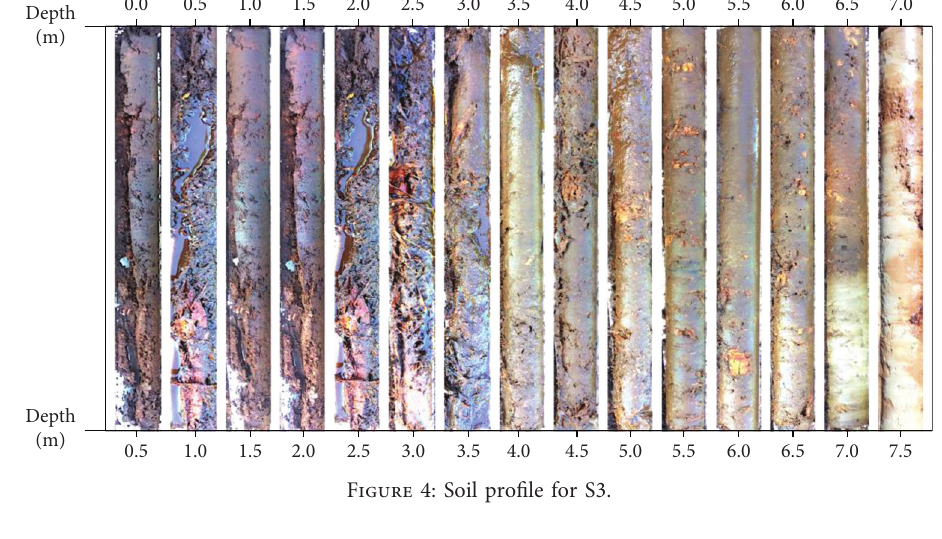
Figure 4: Soil profile for S3.